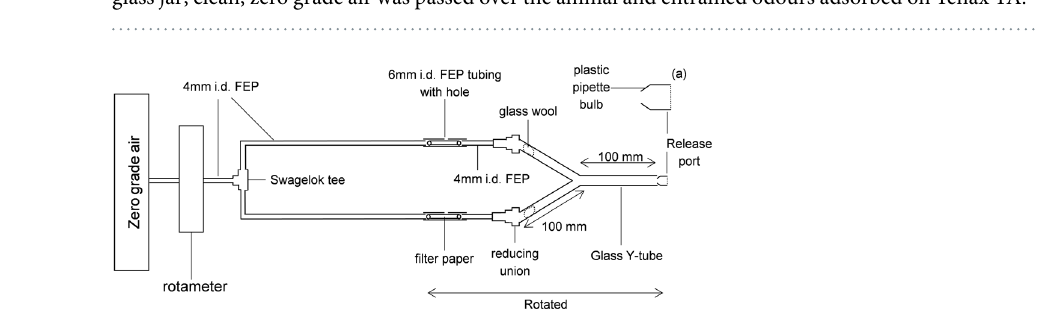
Figure 1. Odour entrainment apparatus. To collect the odours of M. auratus , the animal was placed in a 2 L glass jar; clean, zero grade air was passed over the animal and entrained odours adsorbed on Tenax TA.